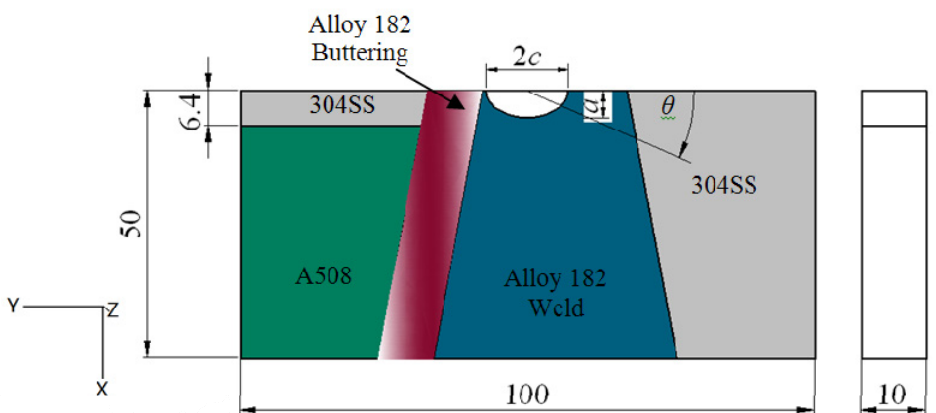
Figure 2: Geometry of the DMW joint sub-model.